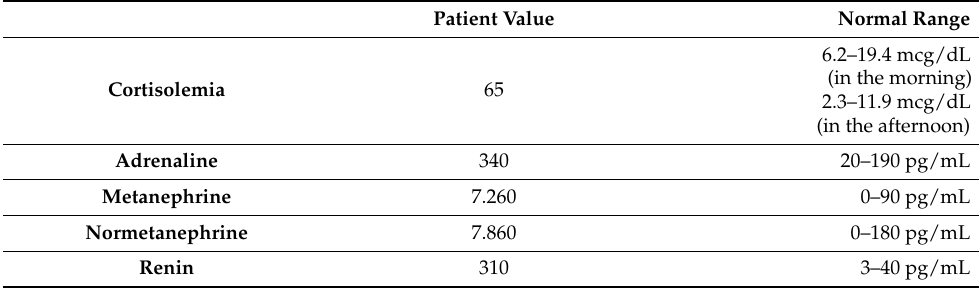
Table 4. Blood chemistry results when the patient was admitted to intensive